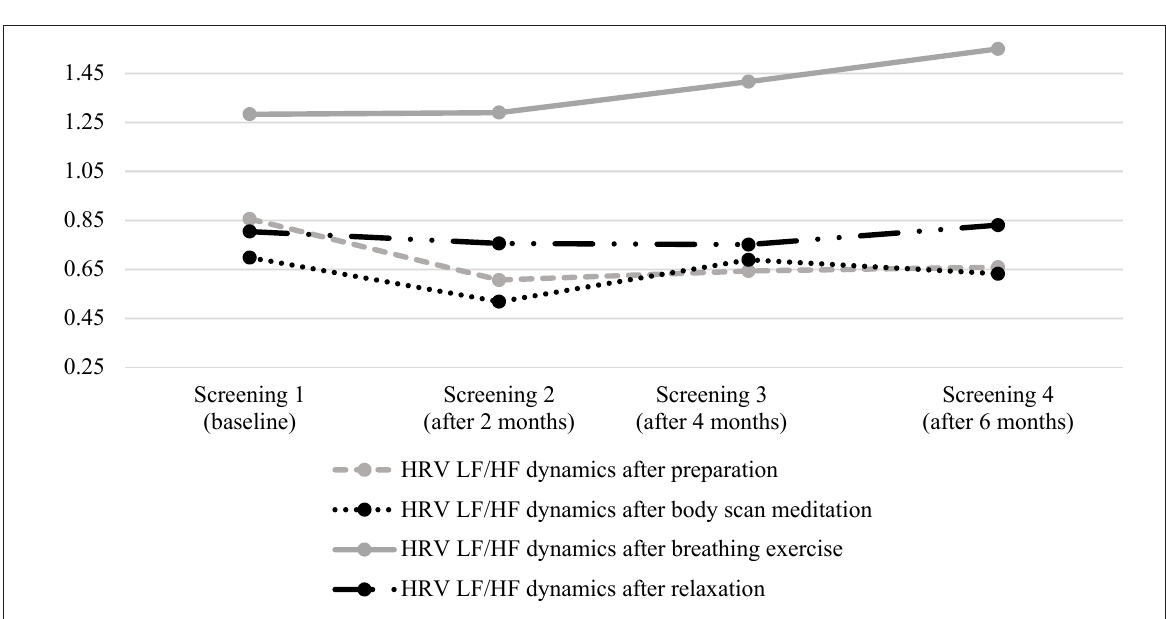
Figure 6. HRV LF/HF dynamics during 6-month period